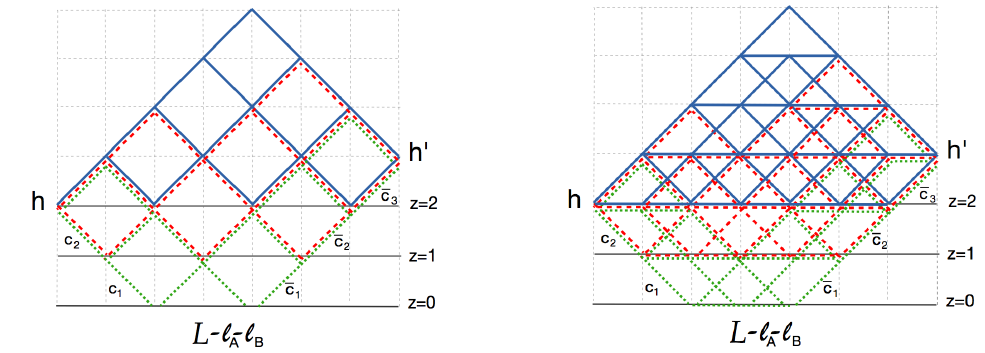
Figure 3: Examples of Dyck (left) and Motzkin (right) paths to be taken in a central − (cid:96) = 7 after a tripartition, which start at height h = 2 region C of length L − (cid:96) A B and end at height h (cid:48) = 3, classified by touching at least once, but not crossing, the horizontal lines z = 0,1,2. The solid blue lines are all the paths which touch z = 2, ( 7 ) 〉 that contribute to | P , the dashed red lines are all the paths which touch z = 1, ¯ c 3 01 ( 7 ) 〉 that contribute to | P , the dotted green lines are all those which touch z = 0, c 2 ,¯ c 2 ,¯ c 3 12 ( 7 ) 〉 that contribute to | P c 2 , c 1 ,¯ c 1 ,¯ c 2 ,¯ c 3 23